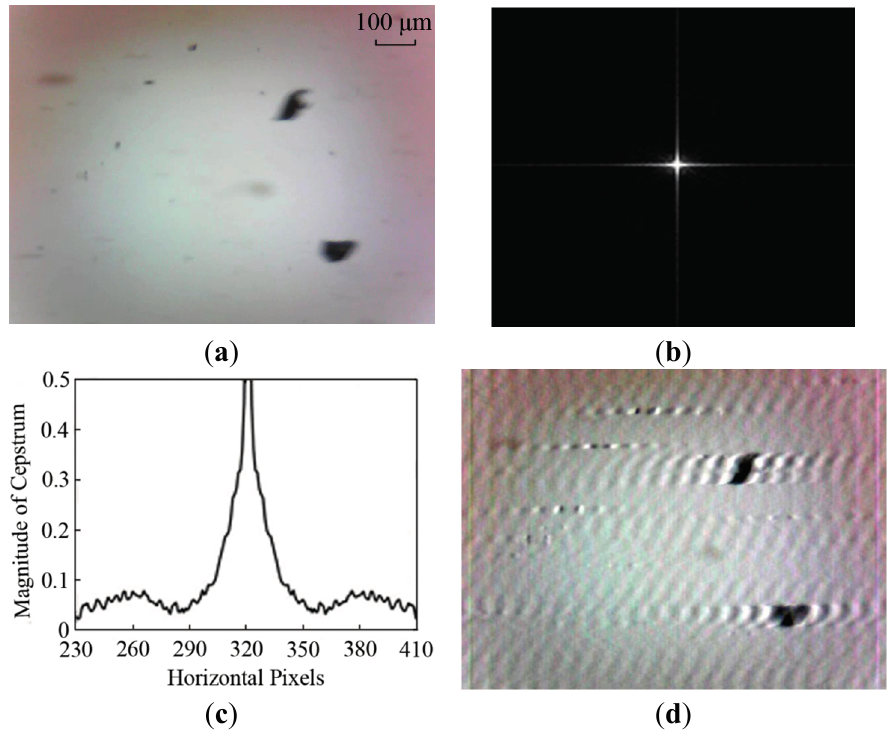
Figure 4. Restored results based on the whole image: ( a ) dynamic wear debris image; ( b ) power cepstrum; ( c ) cepstrum Magnitude; and ( d ) output